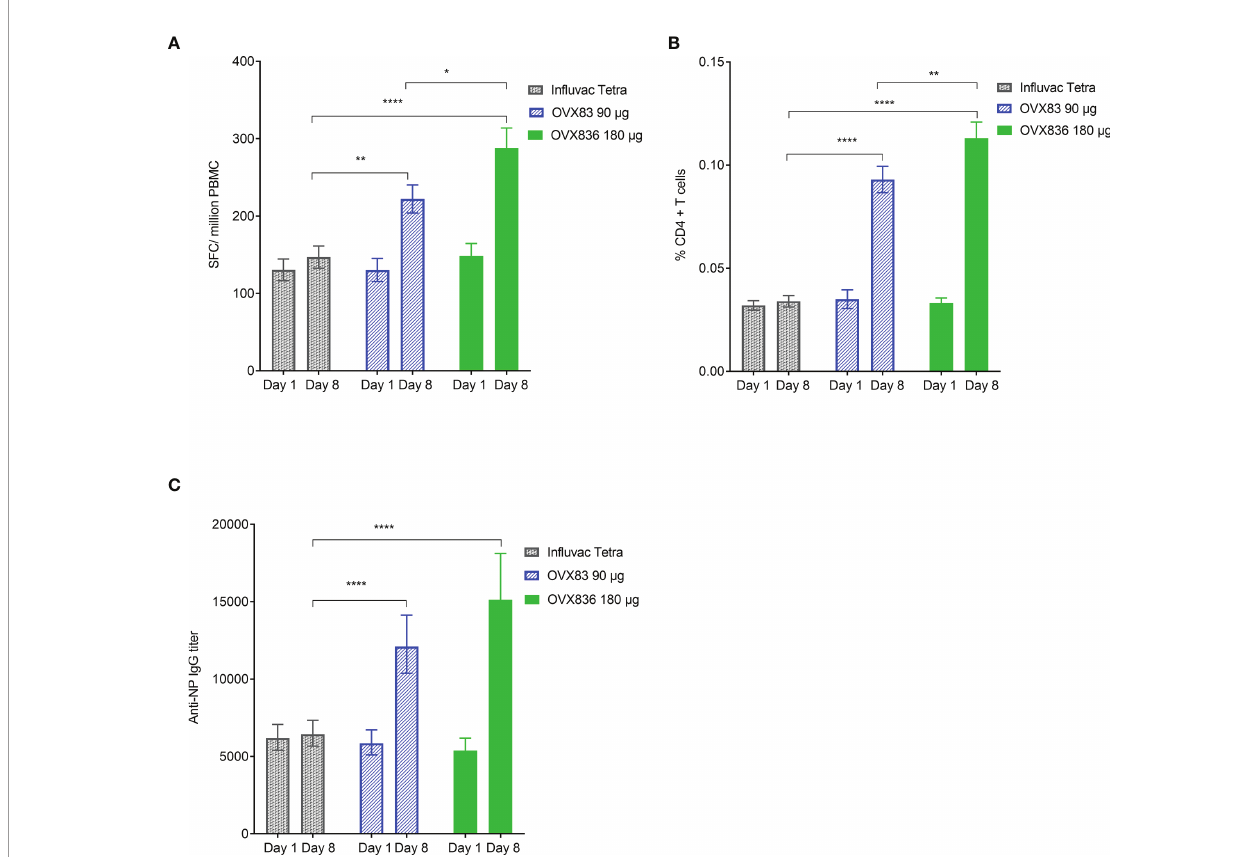
FIGURE 3 | Panel (A) Number of nucleoprotein (NP)-speci fi c interferon-gamma (IFN g ) spot forming cells (SFCs) per million peripheral blood mononuclear cells (PBMC) at baseline (Day 1 – pre-vaccination) and Day 8 (post-vaccination) in the three treatment groups (In fl uvac Tetra ™ , OVX836 90µg and OVX836 180µg; modi fi ed intention-to-treat cohort after elimination of two outlier subjects with very high values at baseline). Results are shown as mean ± standard error; intergroup comparisons: *p<0.05; **p<0.01; ****p<0.0001. Panel (B) Percentage of NP-speci fi c CD4+ T-cells positive for at least IFN g at baseline (Day 1 – pre-vaccination) and Day 8 (post-vaccination) in the three treatment groups (modi fi ed intention-to-treat cohort). Results are shown as mean ± standard error; intergroup comparisons: **p<0.01; ****p<0.0001. Panel (C) Anti-NP immunoglobulin G (IgG) titers at baseline (Day 1 – pre-vaccination) and Day 8 (post-vaccination) in the three treatment groups (modi fi ed intention-to-treat cohort). Results are shown as geometric mean titers ± 95% con fi dence interval; intergroup comparisons: